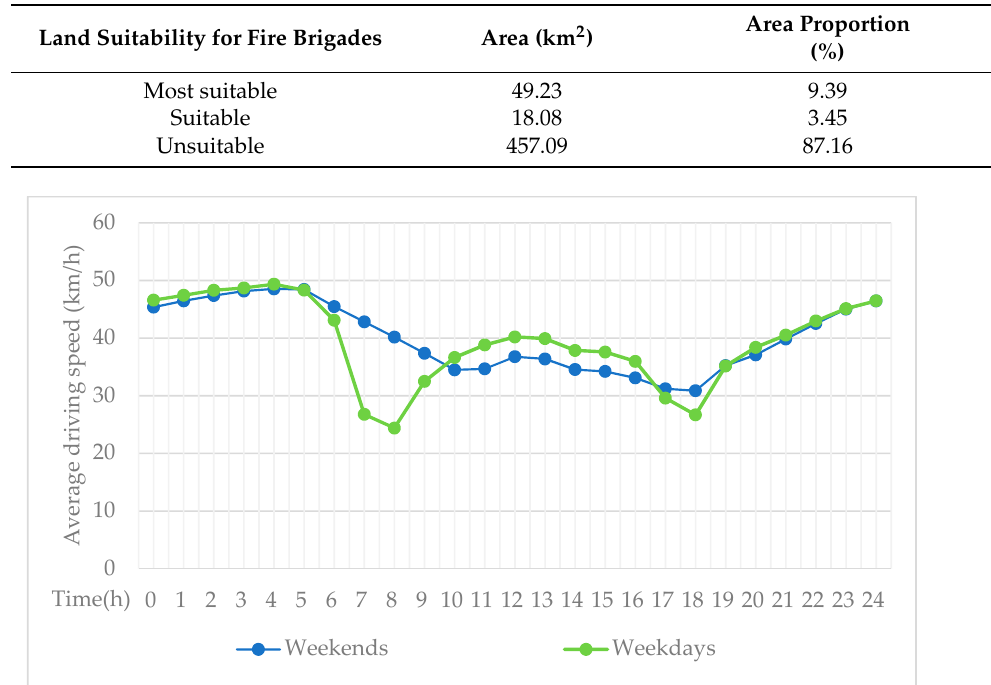
Figure 10. Average vehicle speed as a function of time.